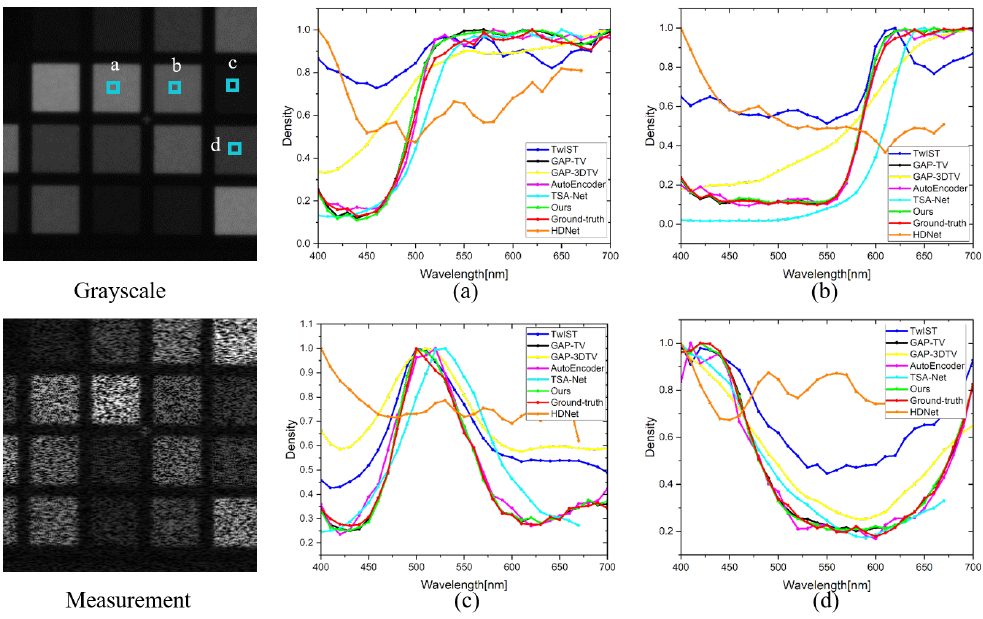
Figure 10. Grayscale image and corresponding compressive measurement by the spatio-spectral encoding from the KAIST dataset. The right two columns display the reconstructed spectral curves on special regions to compare the spectral accuracy. ( a ) The spectral curves at point a; ( b ) The spectral curves at point b; ( c ) The spectral curves at point c; ( d ) The spectral curves at point